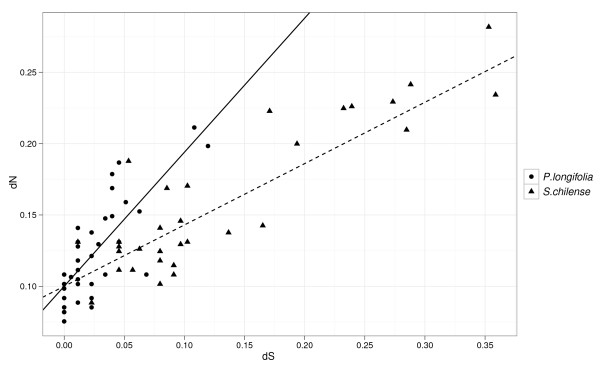
Linear regression of P. longifolia and S. chilense terminal branch estimates of dN and dS. Slopes for P. longifolia (solid black line) and S. carolinense (dashed line) are 0.77 (S.E. 0.08) and 0.42 (S.E. 0.03) respectively with non-significantly different y-intercepts. Terminal branch estimates of dN and dS were obtained using PAML.